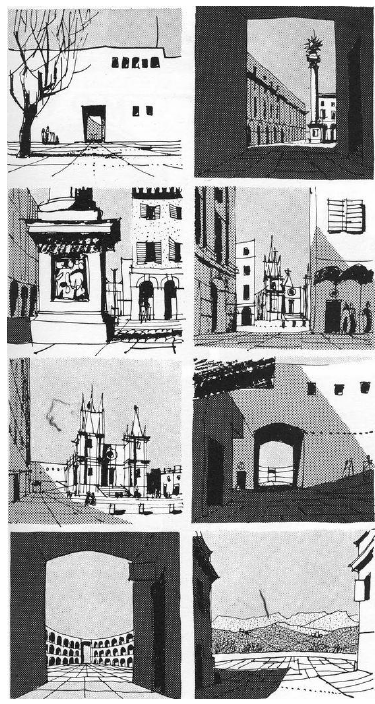
Figure 7. Serial vision as a method of assessing special connectivity. (Cullen,